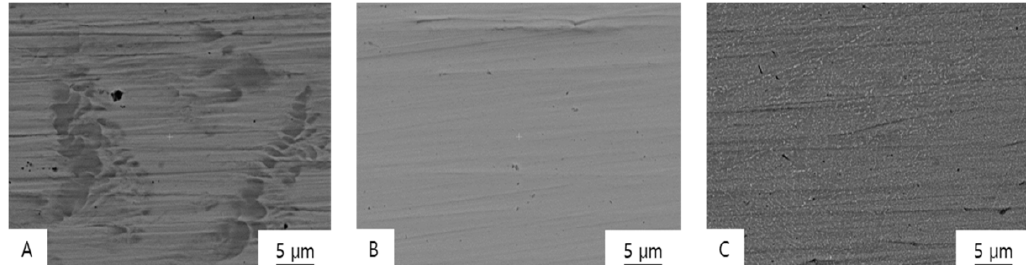
Figure 8. SEM images of the fractured surfaces of Co-Cr alloy specimens formed by means of ( A ) casting (4000 × ; red arrows indicate dendritic structures), ( B ) milling (4000 × ; red lines signify striations), and ( C ) SLM (4000 × ; red arrows indicate cleavage steps).